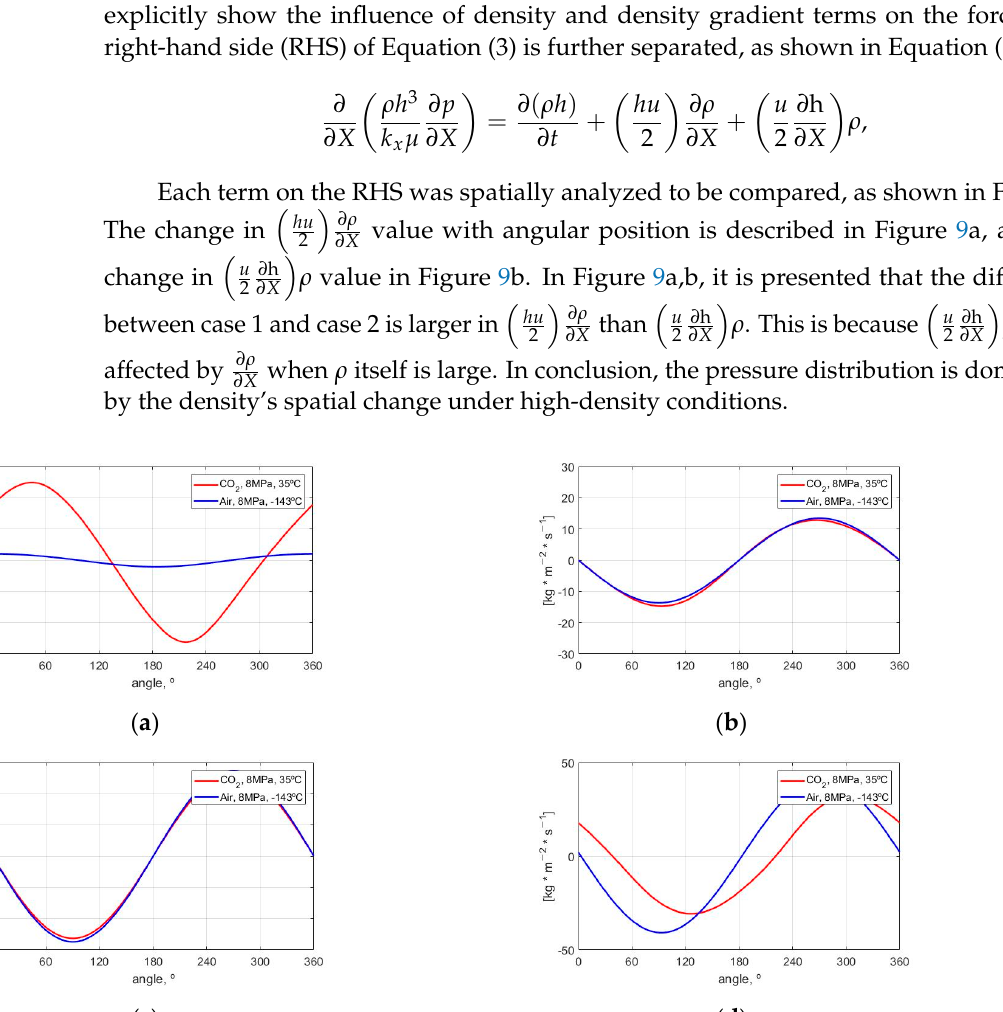
(cid:16) (cid:16) (cid:17) (cid:17) ∂ρ (cid:3105)(cid:2918) hu u ∂ h (cid:4673) (cid:3105)(cid:3096) (cid:4673) 𝜌 , ( c ) (cid:3105)((cid:3096)(cid:2918)) , ( b ) (cid:4672) (cid:3048) , and ( d ) the left-hand side (LHS) value of Equation (13) ρ , ( c ) ∂ ( ρ h ) , ( b ) , and ( d ) the left-hand side (LHS) value of Equation (13) 2 2 ∂ X ∂ X ∂ t (cid:2870) (cid:3105)(cid:3025) (cid:2870) (cid:3105)(cid:3025) (cid:3105)(cid:3047) Table 1. Forces acting on the shaft with various conditions ( 𝜀 = 0.25 and 30,000 rpm) Thermal Condition